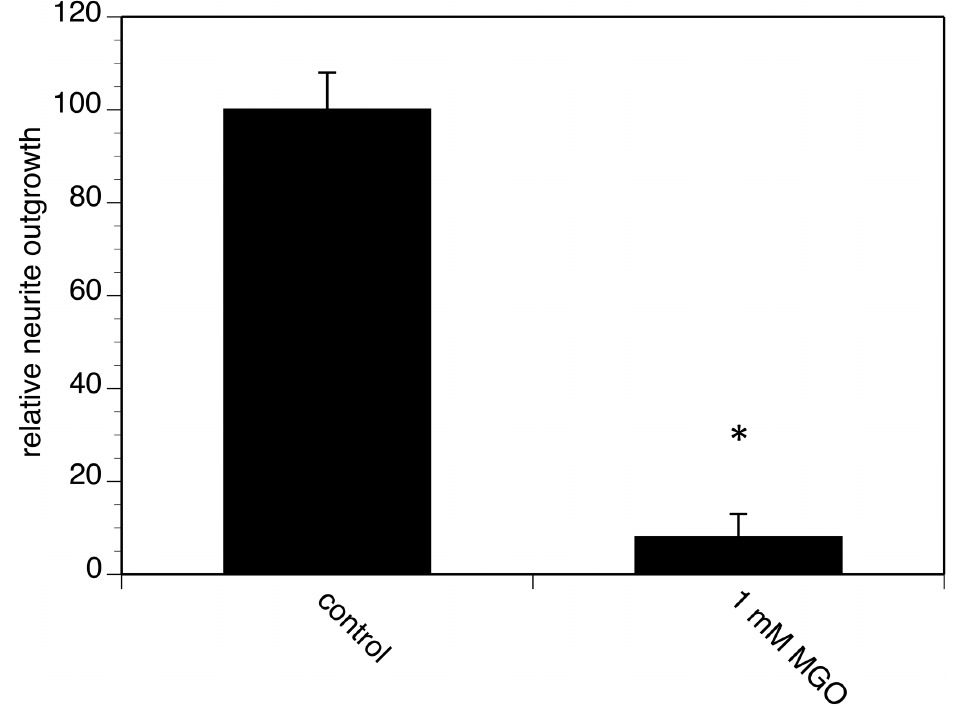
Figure 7. Real-time analysis of neurite outgrowth of AGE-modified PC12 cells. PC12 cells were AGE-modified using 1 mM MGO for 4 h as shown in Figs. 4 &5. Cells were cultured on LN-coated E-plates and neurite outgrowth was induced by application of 100 ng/ml NGF. Neurite outgrowth was continuously quantified over 48 hours by RTCA as described in Pollscheit et al. (2012). Total neurite outgrowth of non-modified control cells during 48 h was set to 100% and neurite outgrowth of AGE-modified cells was expressed in % of control. Bars represent two independent experiments carried out in quadruplicates. doi:10.1371/journal.pone.0112115.g007 PLOS ONE |